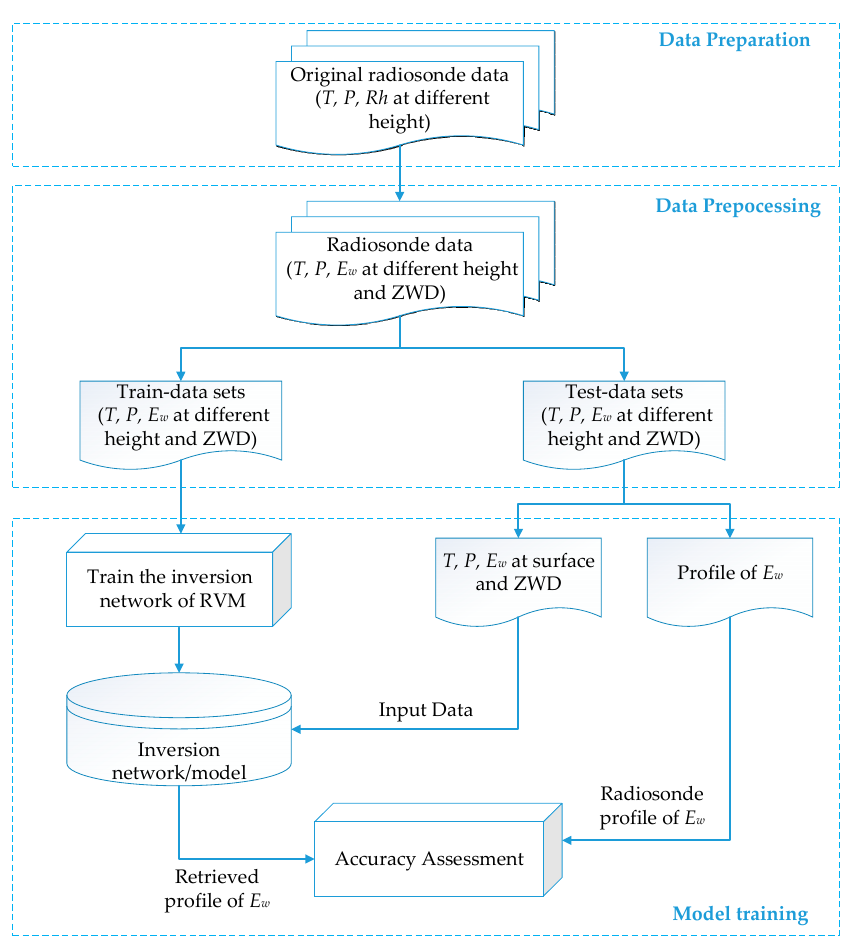
Figure 4. Flow diagram of training procedure for retrieving profile of water vapor pressure.